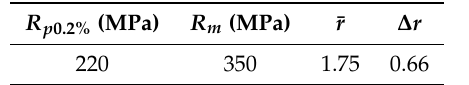
Table 1. Measured mechanical properties of E220BH steel. R p 0.2% is the conventional elastic limit and R m is the tensile